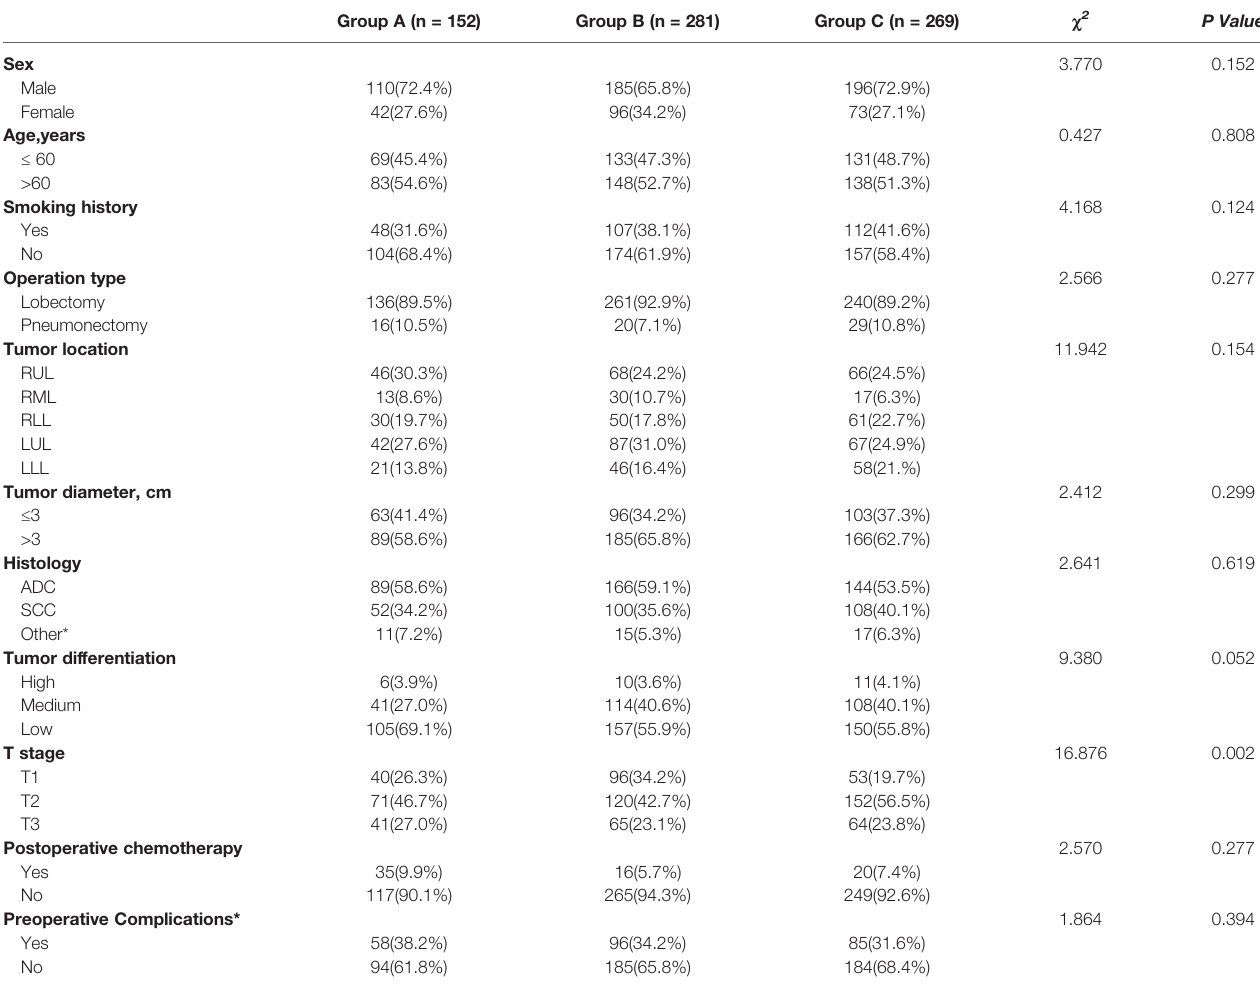
TABLE 1 | Baseline characteristics of the study